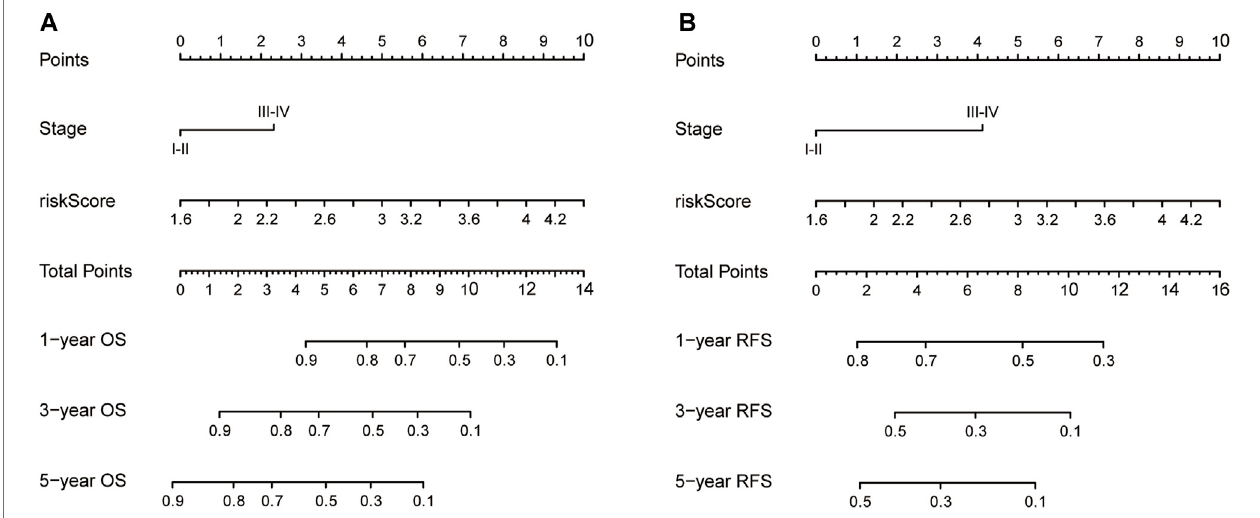
FIGURE 7 | The construction of OS (A) and RFS (B) predictive nomogram for HCC patients. Notes: OS: overall survival; RFS: recurrence-free survival.